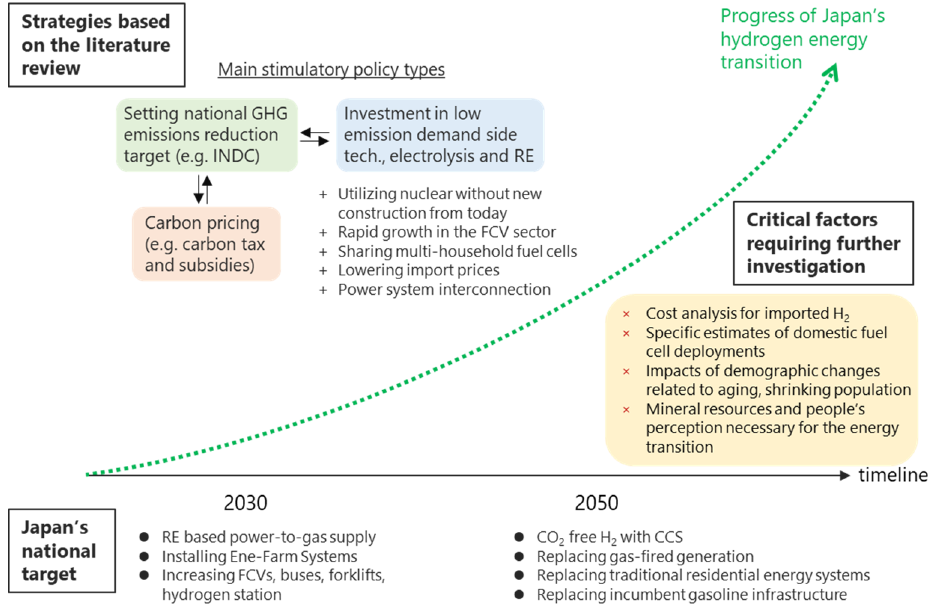
Figure 1. Schematic figure of strategies and future perspectives obtained from this study for Japan’s hydrogen energy transition.